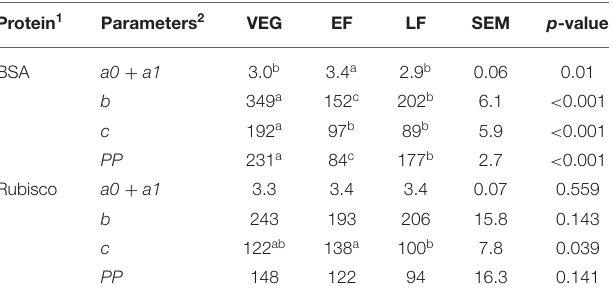
TABLE 5 | Parameters of precipitating capacities of CT from leaves of PPC ( Dalea purpurea Vent) harvested at VEG, EF, or LF. Protein 1 Parameters 2